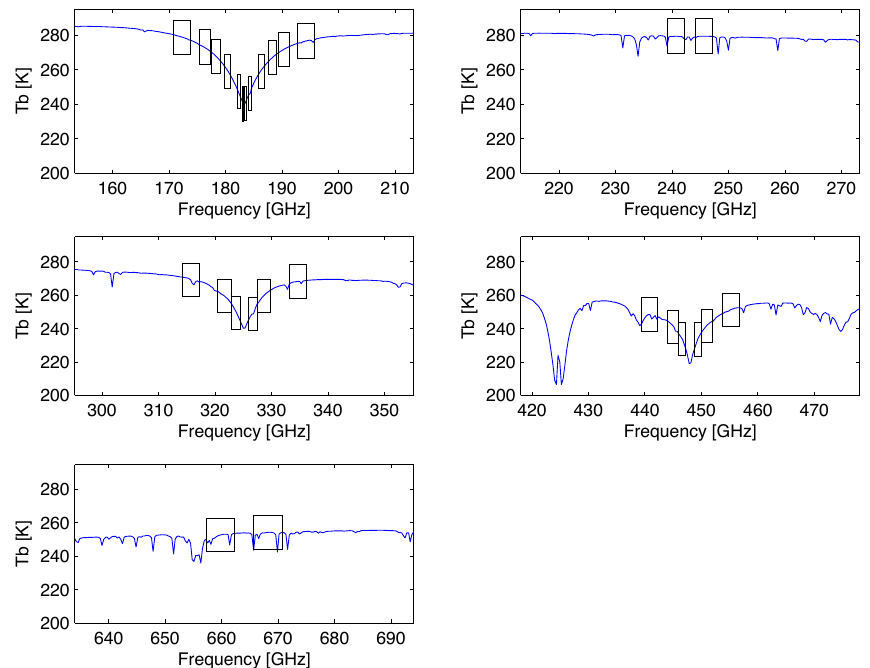
Fig. 3. A detailed view of the CloudIce channel positions. The spectrum shown is the simulated clear-sky radiance (in Planck brightness temperature units) for a tropical model atmosphere. Each channel consists of two sidebands, located on either side of a central frequency. The heterodyne technique used implies that only a single measurement value is recorded for the integrated radiance in both sidebands. The atmospheric scenario is from Anderson et al.